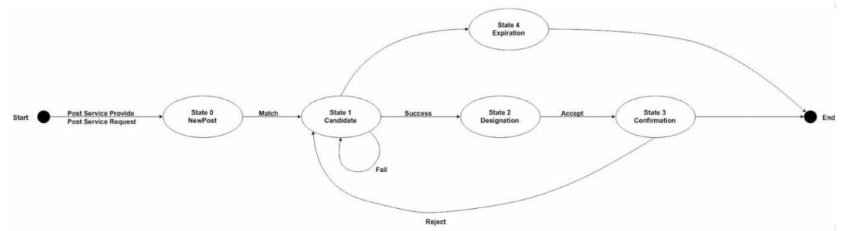
Figure 4. The transition diagram of the corresponding state machine of the service